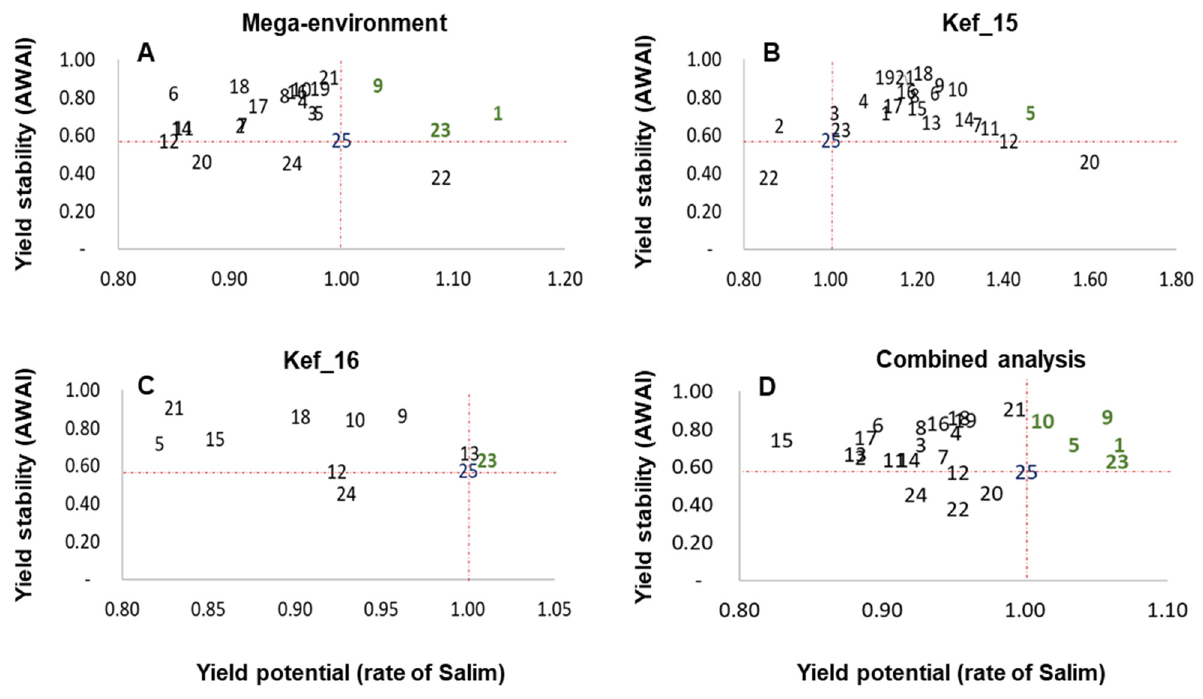
Figure 2. Combined analysis using yield stability (AWAI) compared to the yield ratio of Salim for each environment separately ( A – C ) and for all environments ( D ). Green lines are more stable and better yielding than Salim (line 25).